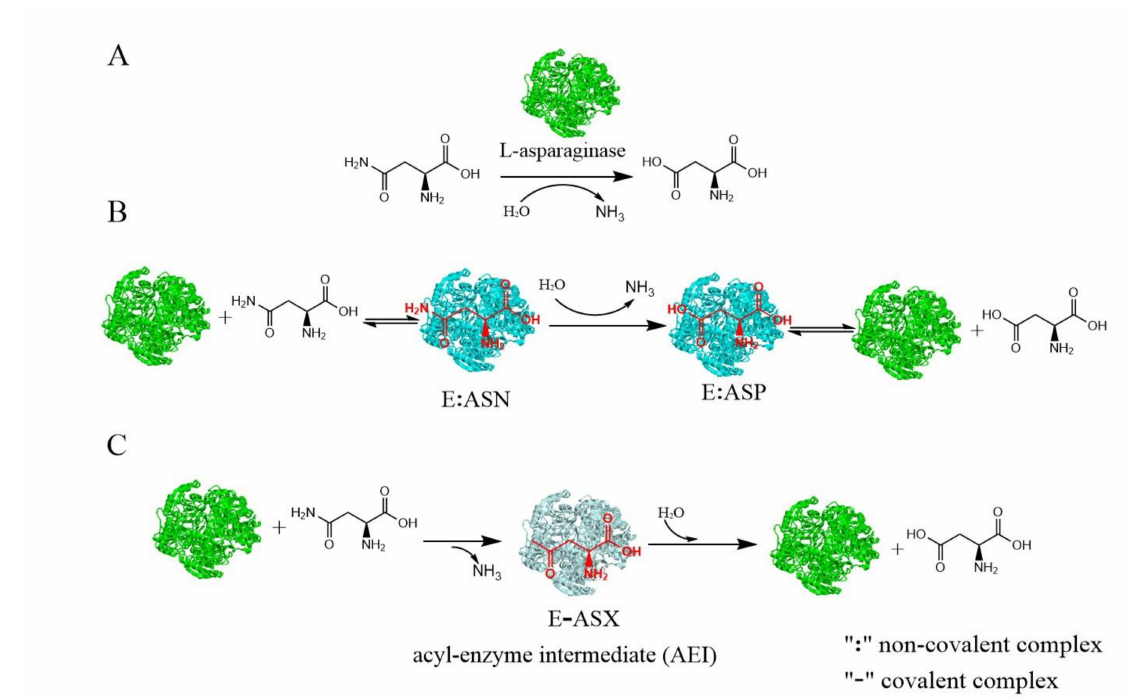
Figure 1. A schematic diagram of the L-asparaginase reaction and its catalytic mechanisms: ( A ) A schematic diagram of the L-asparaginase reaction. ( B ) A schematic diagram of the direct displacement mechanism. ( C ) A schematic diagram of the double-displacement mechanism. Different colors stand for different conformations of the enzyme. (ASN, L-asparagine; ASP, aspartic